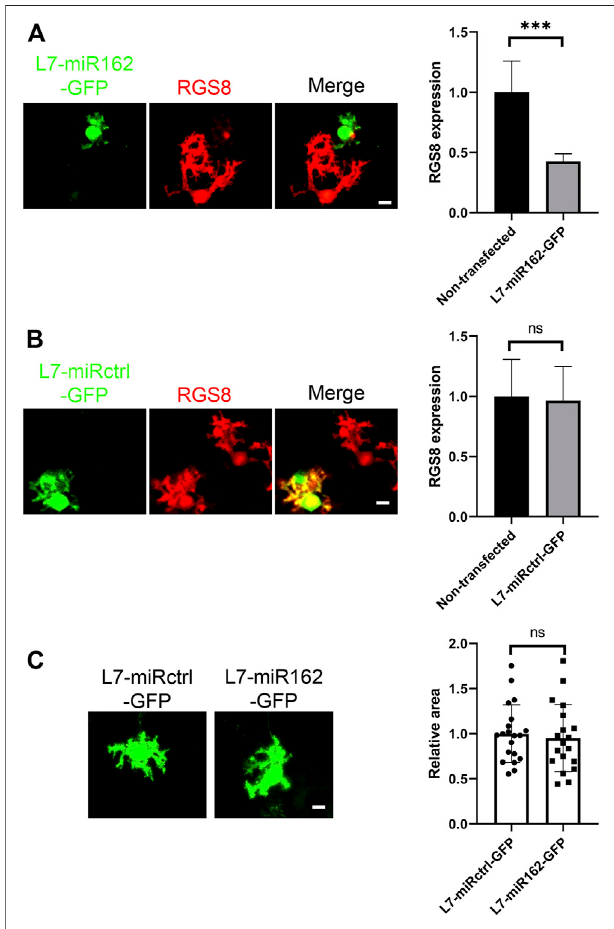
FIGURE 2 | RGS8 silencing by miRNA did not affect Purkinje cell development. (A) The transfected Purkinje cells were identi fi ed by GFP staining in dissociated cultures and RGS8 protein expression was quanti fi ed on GFP-positive Purkinje cells versus neighboring non-transfected Purkinje cells without GFP expression in the culture dish. The mean value of RGS8 expression in L7-miR162-GFP was 0.43 ± 0.064 compared to control cells (1.00 ± 0.260). n = 6, the difference in expression was signi fi cant with *** p < 0.001 in t test. (B) The mean value of RGS8 expression in L7-miRctrl- GFP was 0.96 ± 0.285 compared to control cells (1.00 ± 0.307). n = 6, Differencewasnotstatistically signi fi cantin t test.Scalebar is20 µm.Dataare expressed as mean ± SD. (C) The Purkinje cells transfected with L7-miRctrl- GFP or L7-miR162-GFP were identi fi ed by GFP staining in dissociated cultures. The mean values of dendritic area of the Purkinje cells were measured from three independent experiments; L7-miRctrl-GFP: 1.00 ± 0.320, n = 20 cells; L7-miR162-GFP: 0.95 ± 0.373, n = 19 cells; Difference was not statistically signi fi cant in the two-tailed Mann-Whitney test. Scale bar is 20 µm. Data are expressed as mean ±